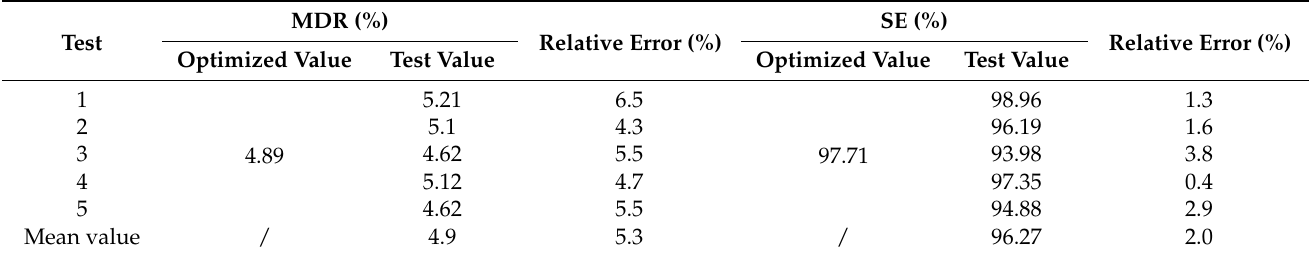
Table 5. Comparison of theoretical value and verification test